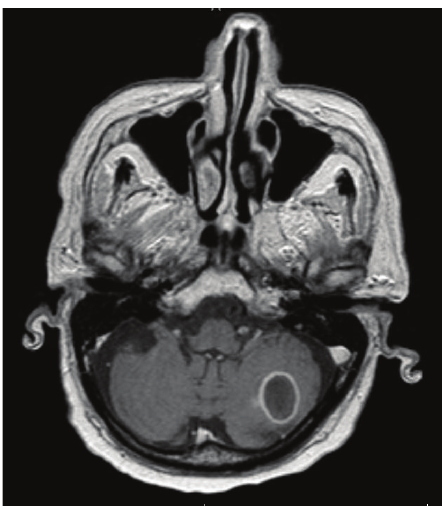
Figure 1: Magnetic resonance imaging of the brain showing ring enhancing lesion in the left parietal lobe, on initial presentation.